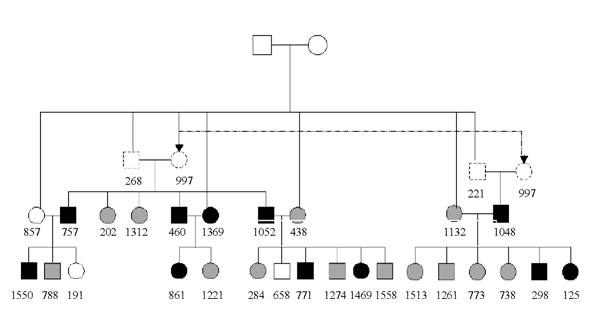
The inbreeding-corrected pedigree. The second, third and fourth generations correspond to COGA pedigree 10022 depicted in Figure 1.